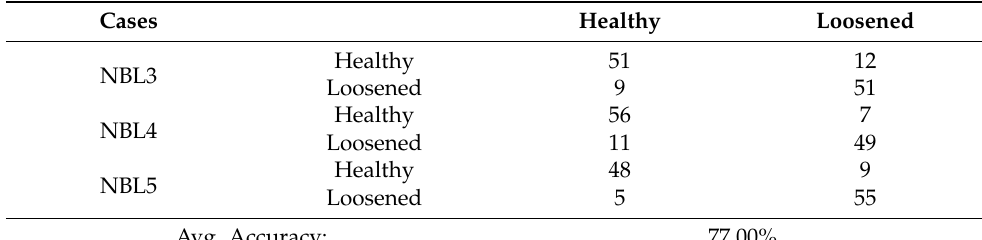
Table 10. Confusion chart shows the average test performance for four storey numerical